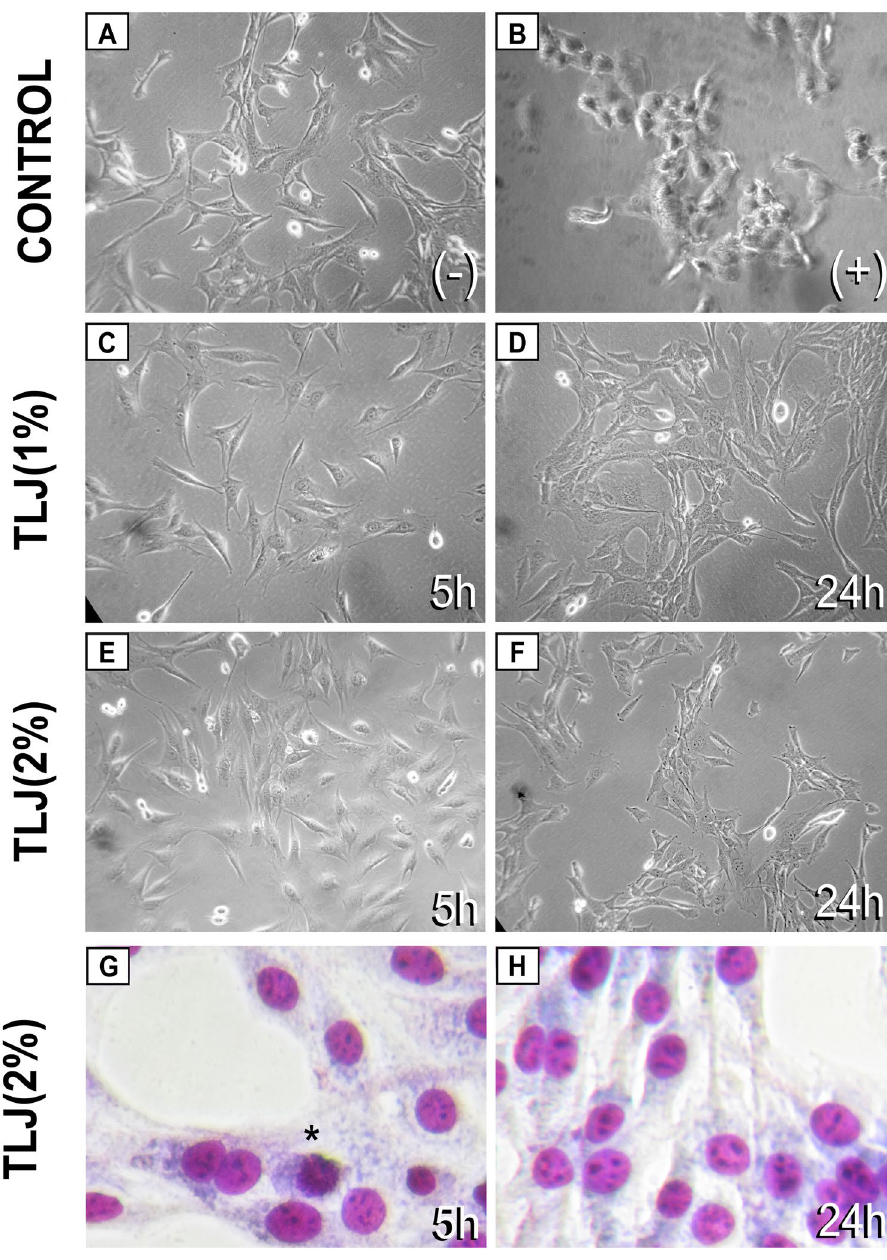
Figure 2. Absence of degenerative signalsof the C2C12 cells exposed to TLJ (1% or 2%) until 24 h, analyzed by phase contrast ( A–F ) or panoptic stain by bright field microscopy ( A–G ). ( A ) Control cells (5 h) without treatment showing normal morphology with some cells with signals of proliferation (small round bright cells). ( B ) Positive control cells treated with H 2 O 2 (11 µ M) at 5 h showing features of loss of viability (detachment). ( C , E ) cells treated at 5 h with 1% or 2% TLJ showing normal morphology (spreading) with some cells in proliferation. ( D , F ) cells treated for 24 h with 1% or 2% TLJ also showing normal morphology with some cells in proliferation. ( G , H ) micrographs of C2C12 cells stained by panoptic showing the normal characteristics in 5 and 24 h after TLJ exposition. ( * ) C2C12 in proliferation showing chromosome